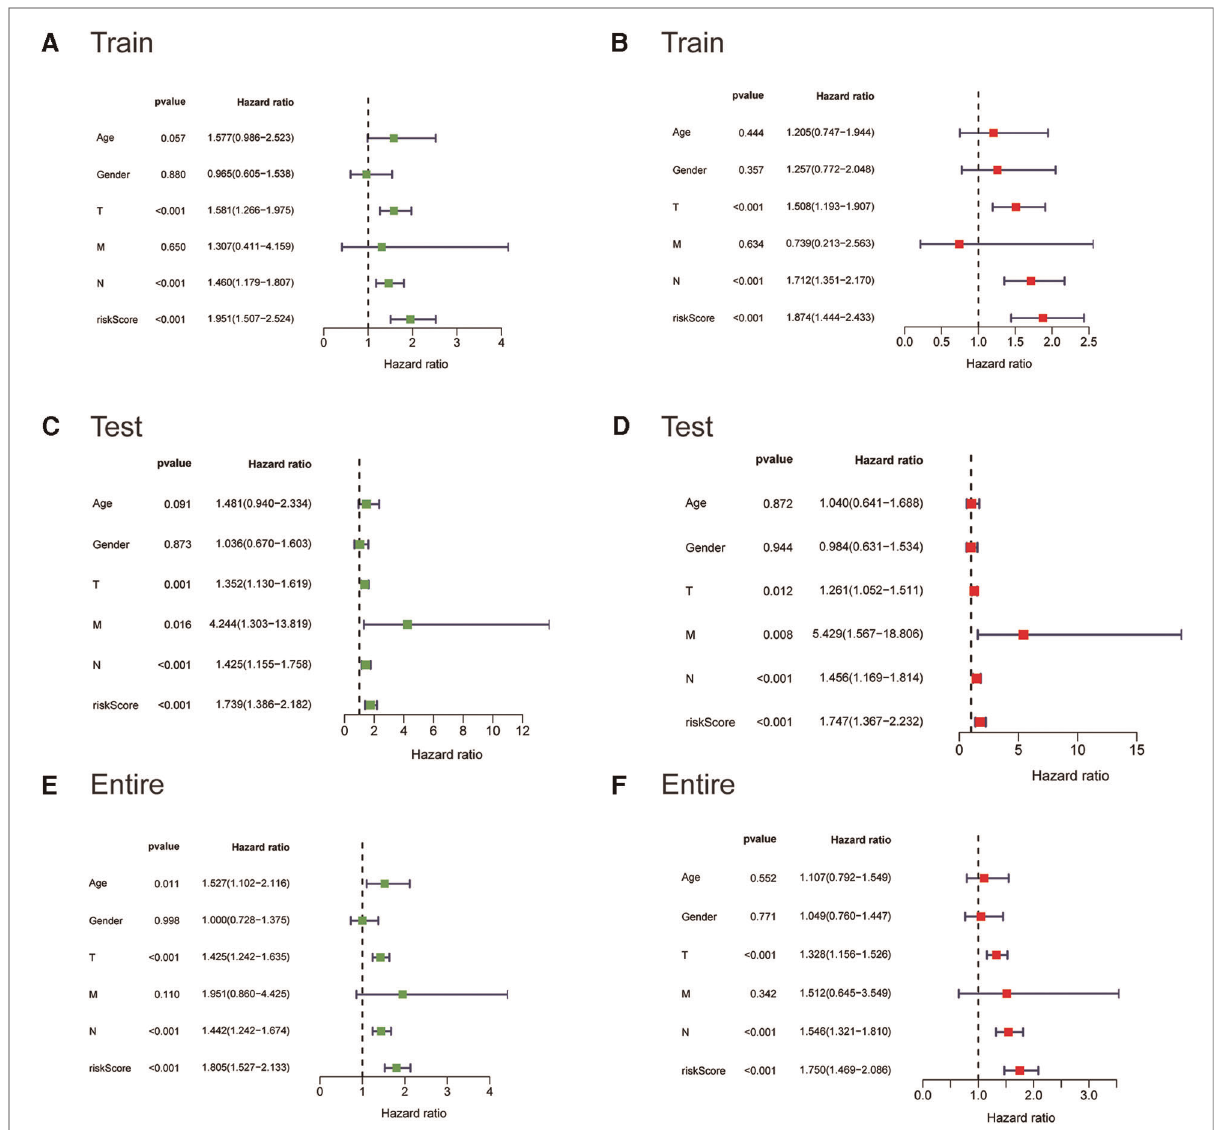
FIGURE 4 The Cox regression analyses for evaluating the independent prognostic value of the risk score. ( A,C,E ) Univariate Cox regression analyses of the association between survival and clinicopathological parameters and risk score for the training, testing, and entire cohorts, respectively. ( B,D,F ) Multivariate Cox regression analyses of the association between survival and clinicopathological parameters and risk score for the training, testing, and entire cohorts,